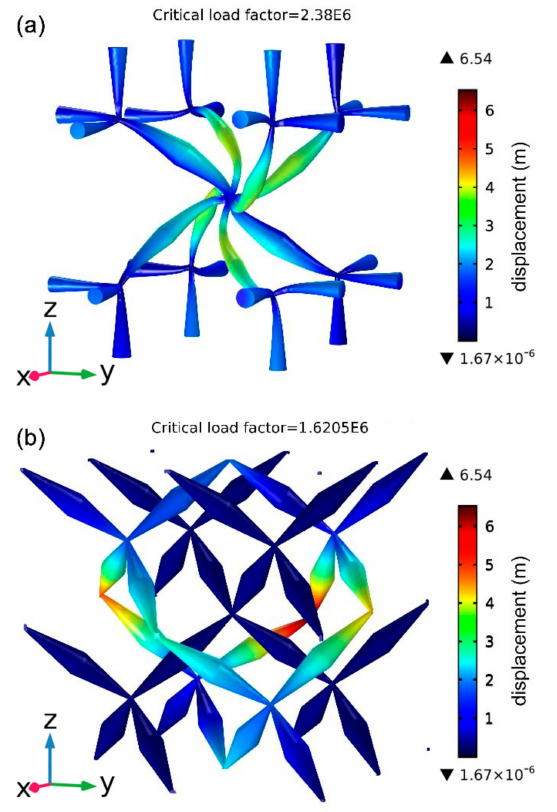
Figure 4. Stability comparison between ( a ) the new pentamode structure (a = 37.3 µ m, D = 2 µ m and d = 0.5 µ m) in this paper and ( b ) the classic pentamode structure (a = 37.3 µ m, D = 3.05 µ m and d = 0.43 µ m). The critical load factors are ( a ) 2.38 × 10 6 and ( b ) 1.62 × 10 6 ,